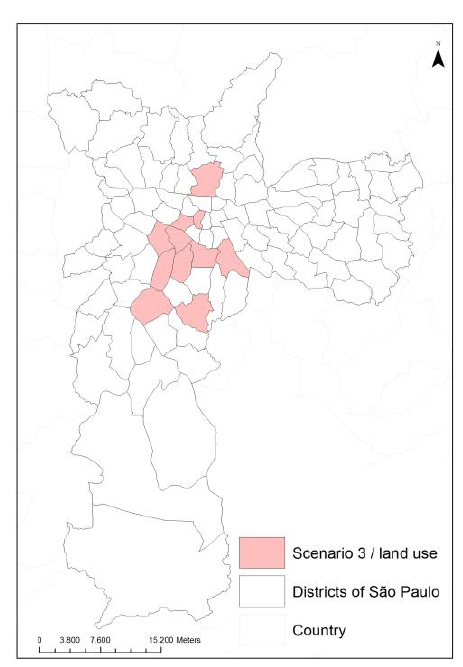
Figure 12. Preferential districts for carsharing system implementation according to scenario 3. (Source: Authors)